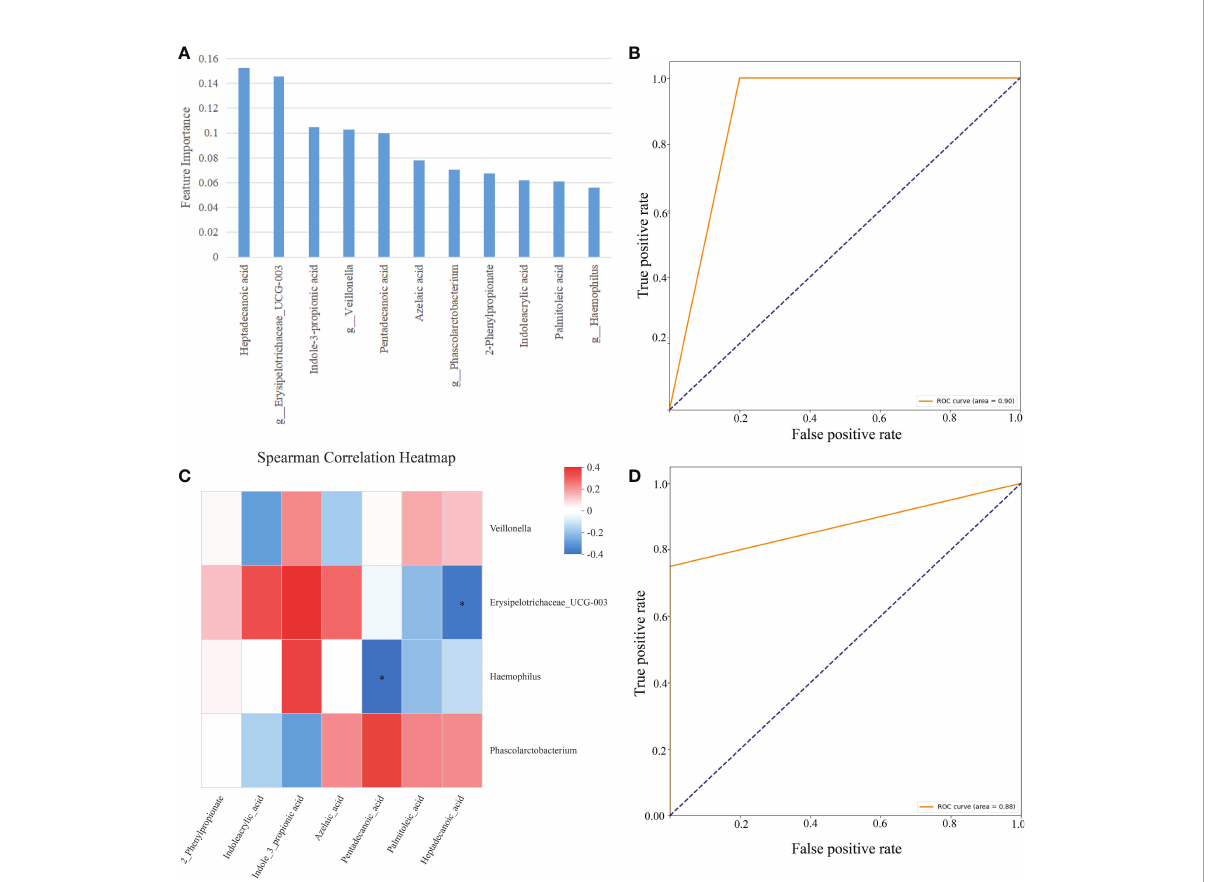
FIGURE 9 Classi fi cation model based on fecal metabolites and gut microbes on the C sample set. (A) The importance in descending order (7 fecal metabolites and 4 gut microbes). (B) Evaluation using ROC curve on the C sample set. (C) Spearman correlation heatmap, Spearman ’ s correlation between 7 fecal metabolites and 4 gut microbes, the abscissa is 7 metabolites and the ordinate is 4 intestinal fl ora, the color scale represents the spearman r value, with red and blue indicating positive and negative correlations, respectively, and *p< 0.05. (D) Evaluation using ROC curve on the C sample set (2 fecal metabolites and 2 gut